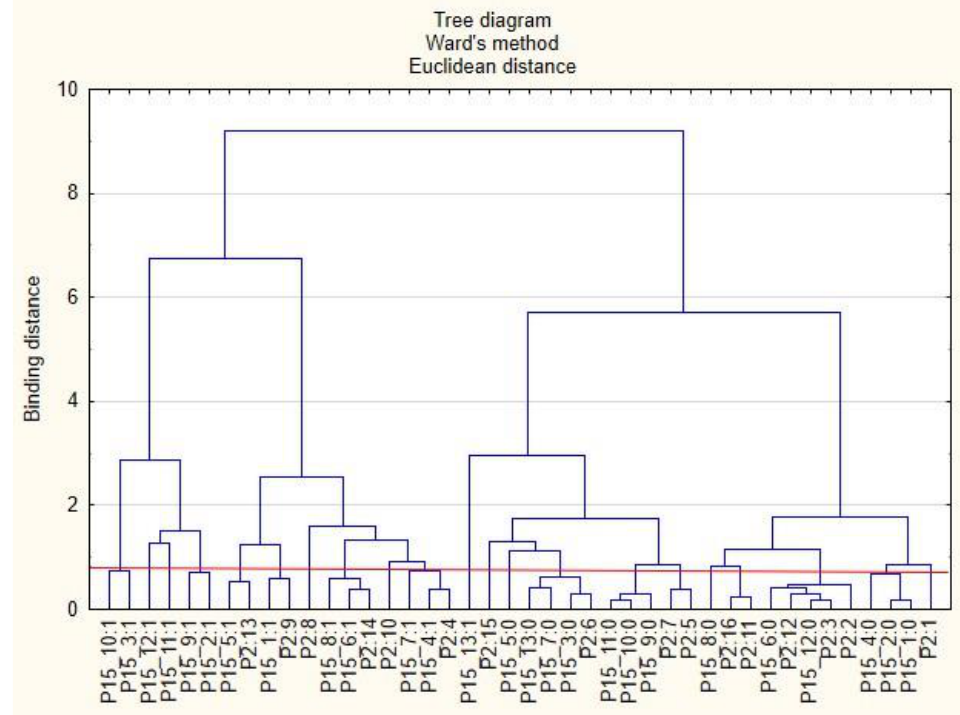
Figure 1. Diagram of hierarchical classification of variable categories: support received during the COVID-19 pandemic from the employer in the area of health care and the effective use of the benefits offered (P15) as well as the voivodeships where the respondents live (P2).